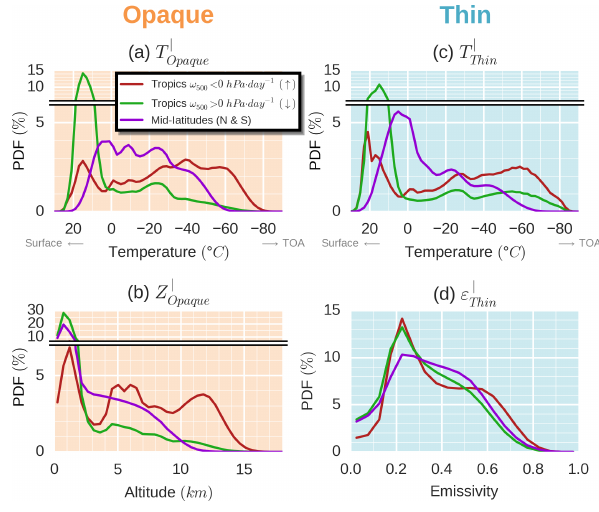
| Figure 4. Observed distributions of (a) T opaque among opaque | | clouds, (b) Z among opaque among opaque clouds, (c) T thin | thin clouds, and (d) ε among thin clouds in three re- thin gions: (red) the tropical ascendance [30 ◦ S–30 ◦ N] (monthly mean ω 500 < 0hPaday − 1 ) , (green) the tropical subsidence [30 ◦ S– 30 ◦ N] (monthly mean ω 500 > 0 hPaday − 1 ) and (purple) the mid- latitudes [30–65 ◦ ]. These regions represent respectively 22, 35, and 43% of the ± 65 ◦ ocean surface. Only nighttime over ice-free oceans for the 2008–2015 period is